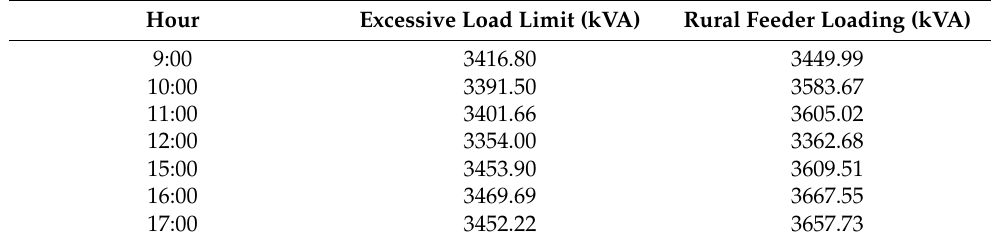
Table 6. Excessive loading limit violations on the Rural Feeder B. Source: The